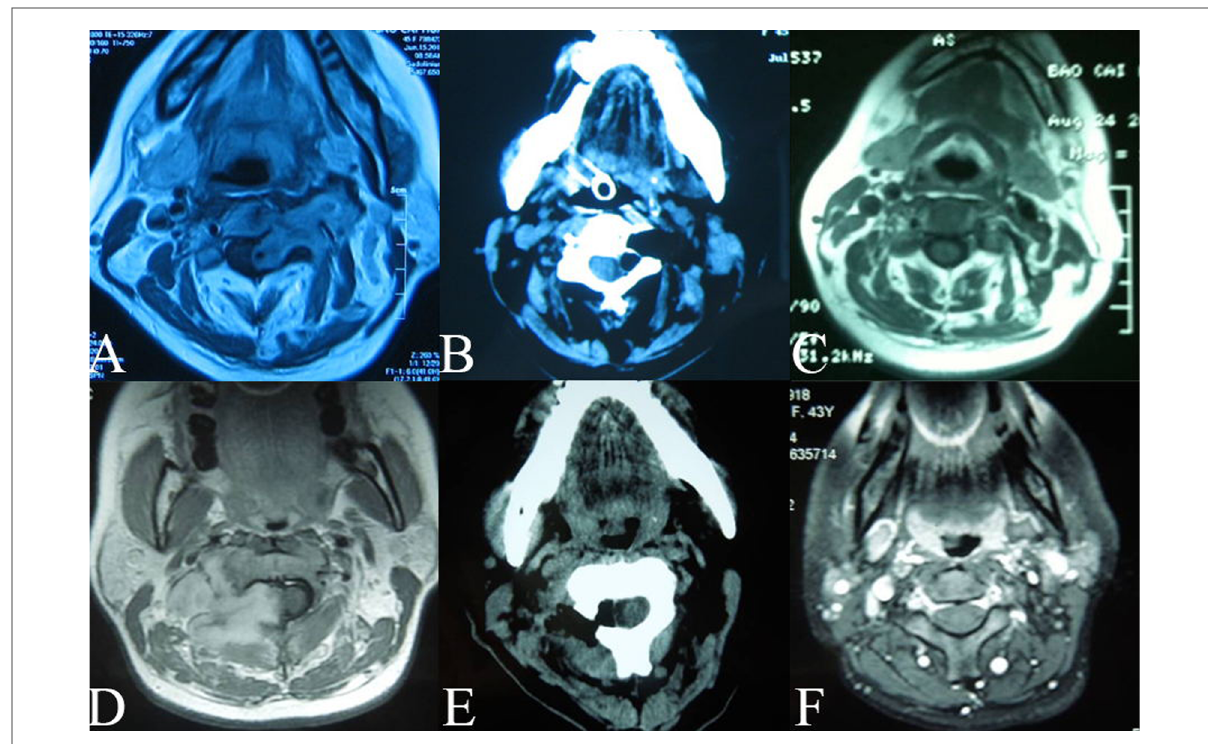
FIGURE 5 Preoperative and postoperative follow-up images ( A. D ): Preoperation images ( B. E ): Postoperative CTs: totall removal of tumors ( C. F ): Postoperative follow-up MRIs: no tumor residual or recurrent.